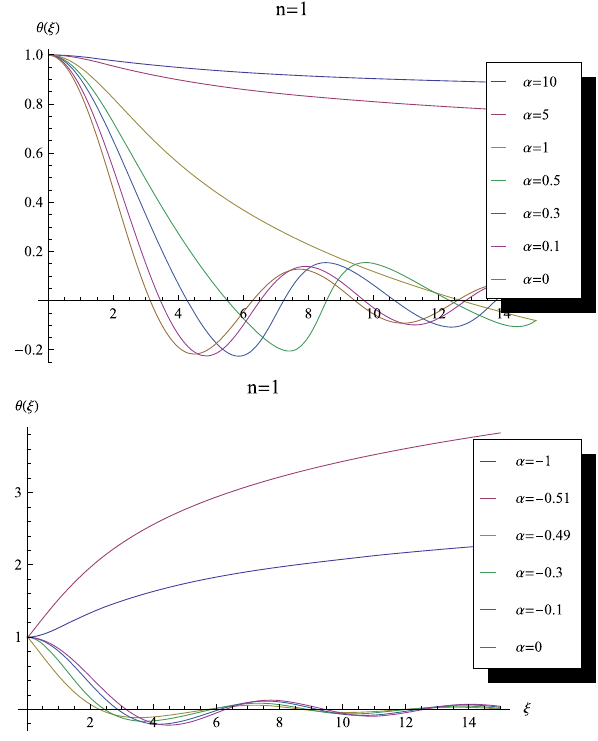
Fig. 1 Plots of the numerical solutions for the case n = 1 for positive (top) and negative (bottom) values of the parameter